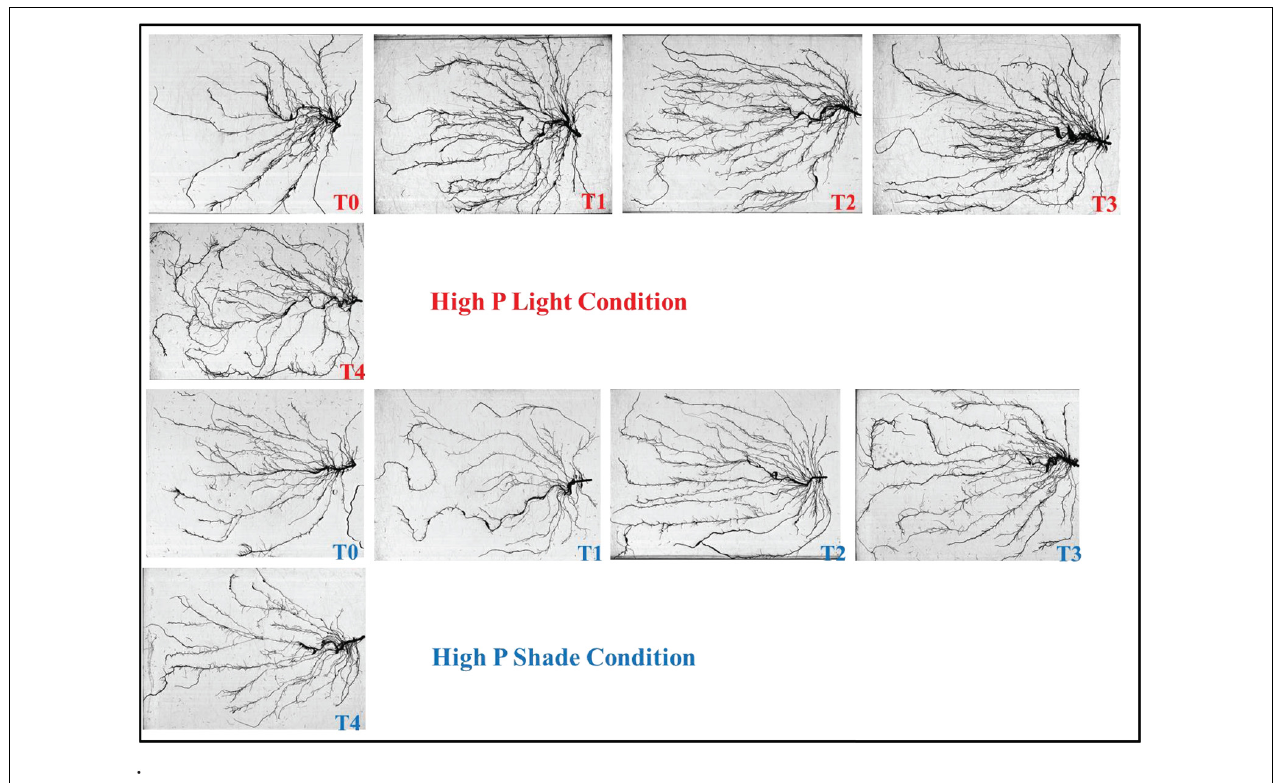
FIGURE 10 | Effect of Ti application on root morphology of the soybean under NL and SC combined with HP conditions.